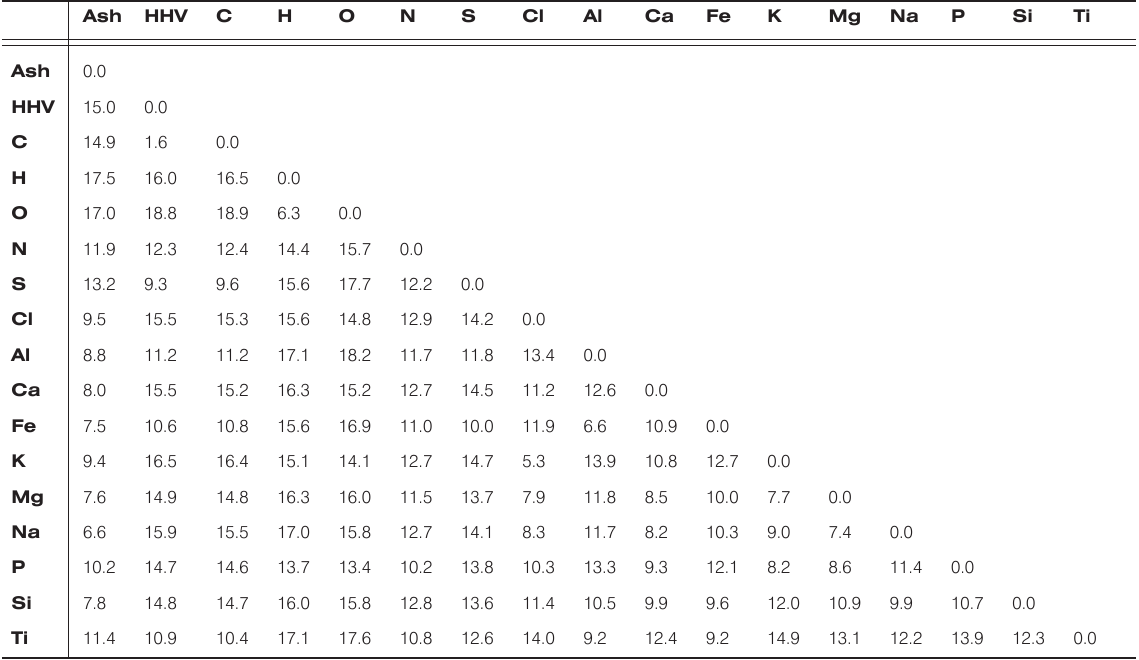
Table 1. Euclidean distance matrix for study